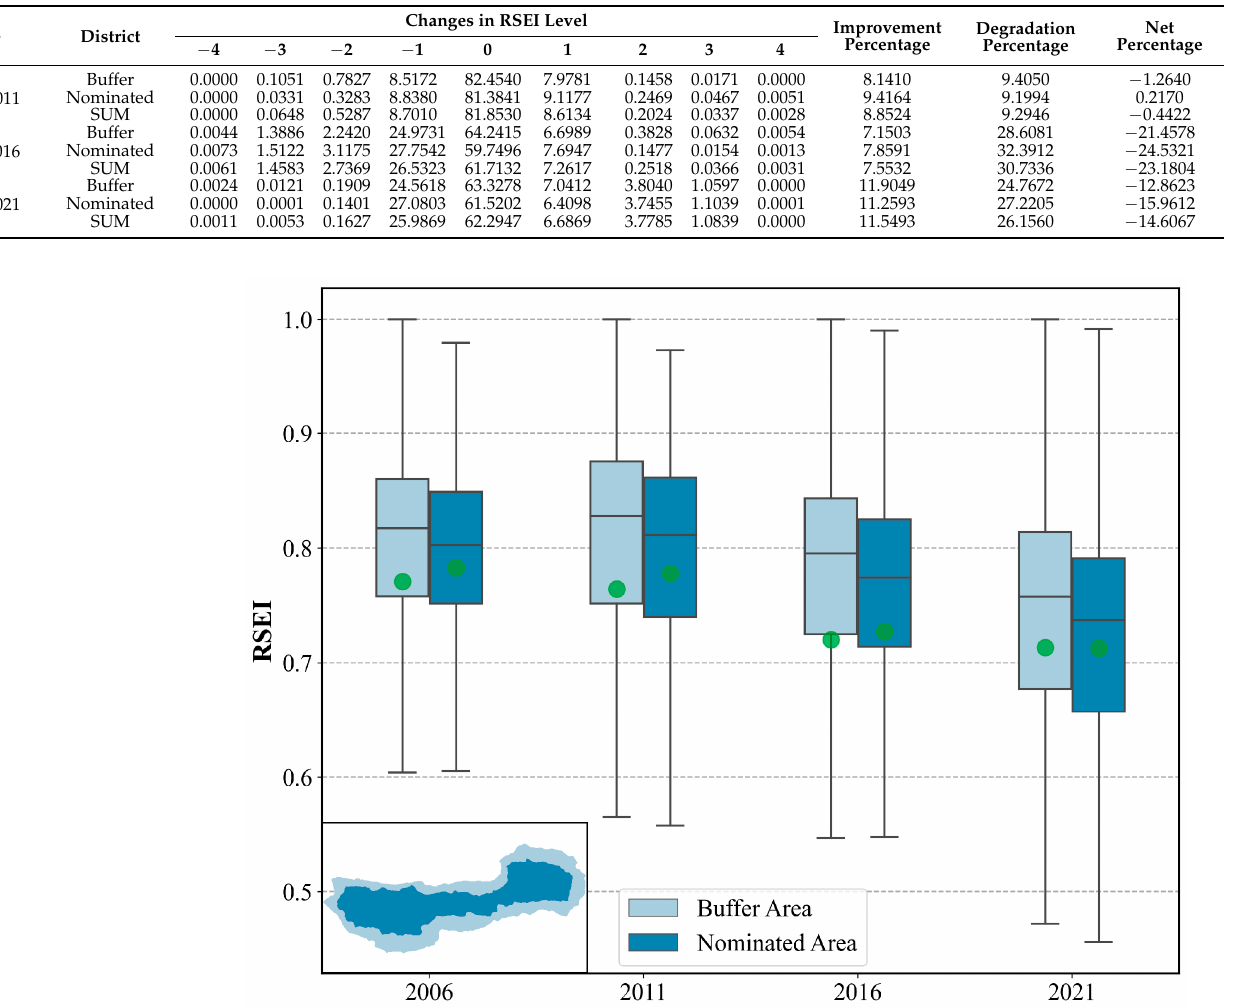
Table 5. Percentage of RSEI grade change statistics in buffer zone and nominated area, 2006–2011,